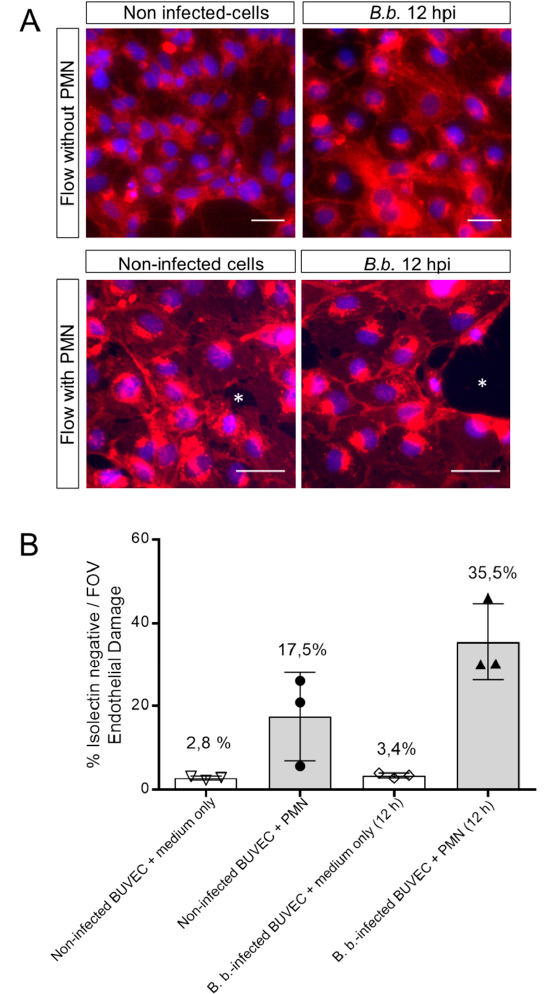
Figure 3. PMN induce damage on B. besnoiti -infected BUVEC under physiological flow conditions. PMN or medium alone were perfused at a constant shear stress of 1 dyn/cm 2 over B. besnoiti -infected and non-infected BUVEC at 12 h.p.i. After 5 min of perfusion, cell layers were fixed and stained with DAPI for nuclei and with Alexa Fluor 594-conjugated isolectin-IB4 that predominantly binds endothelium and observed under fluorescence microscopy. Endothelial damage is calculated dividing the isolectin-negative surface (white asterisks, A , representative images) by the total surface of the field of view. Column graph represents results of the percentage of endothelial damage after analyzing five random pictures from three different BUVEC isolates per each experimental condition ( B ). FOV = Field of view. Number over the bars indicates the mean % and error bars ± SD.